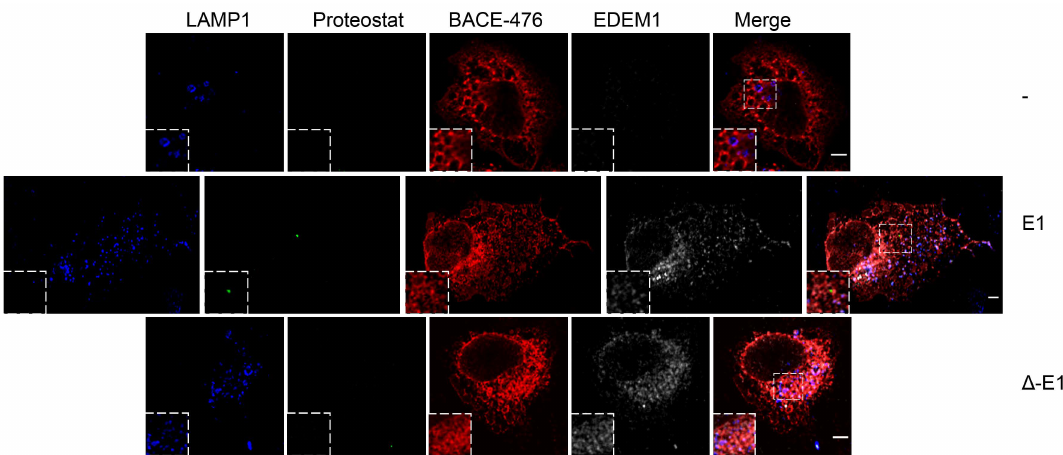
Figure A4. The same experiment as in Figure 5E were performed, and BACE-476, along with an empty vector (-), EDEM1 (E1), or mutant ∆ -EDEM1( ∆ -E1), was co-transfected. The images presented were acquired with confocal microscope and the scale bar on the main image is 5 µ M. Zoom image is 10.5 µ